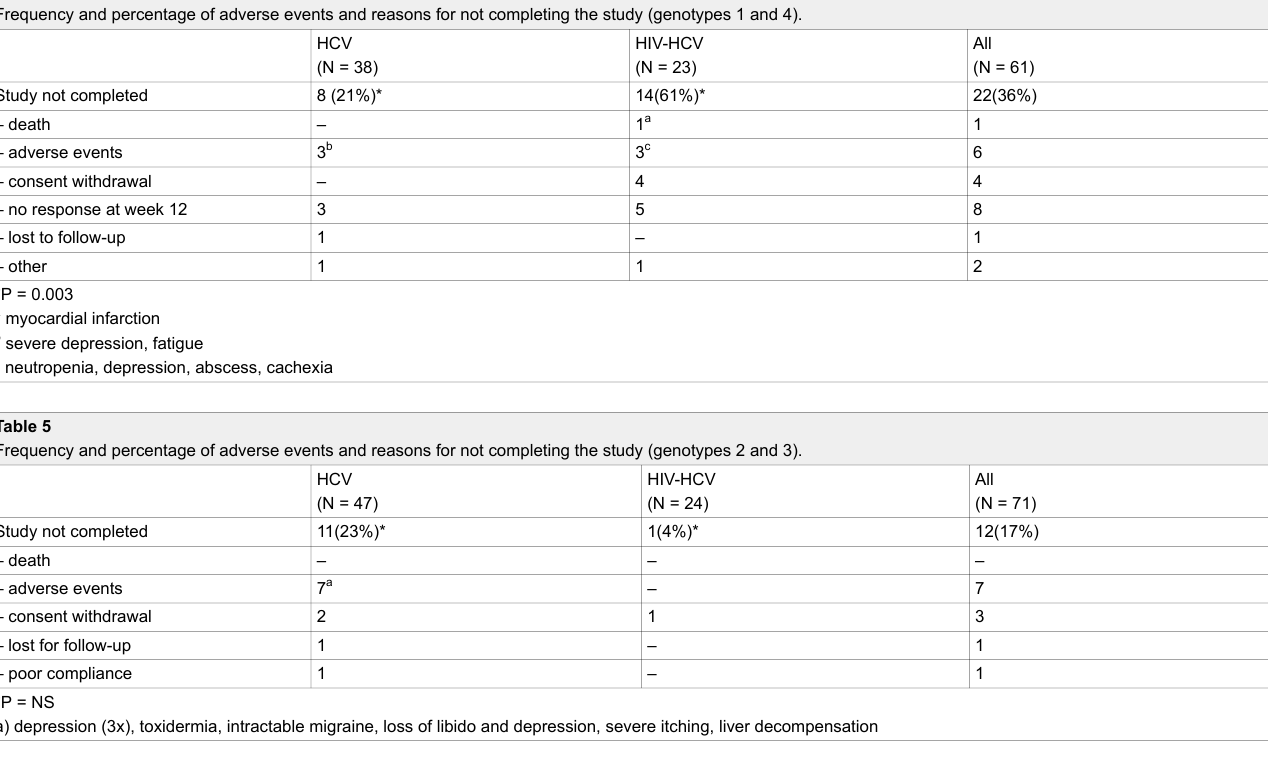
Table 6 Adverse events observed during treatment without leading to treatment